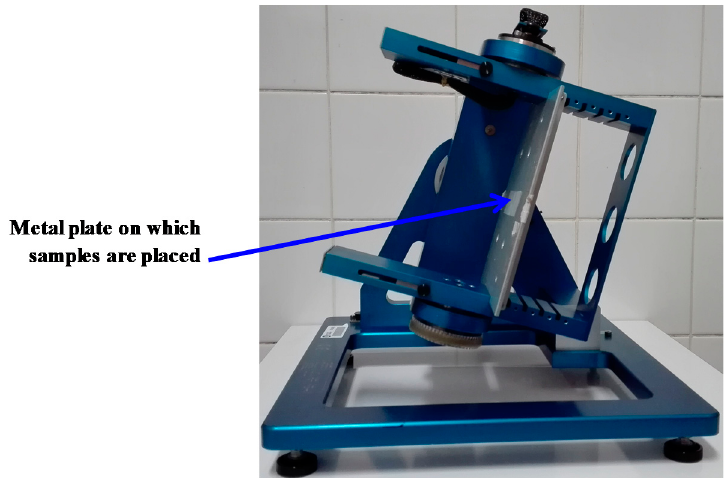
Figure 6. Picture of the random positioning machine (RPM), allowing the exposure of amphibian embryos or tadpoles to simulated microgravity. embryos or tadpoles to simulated